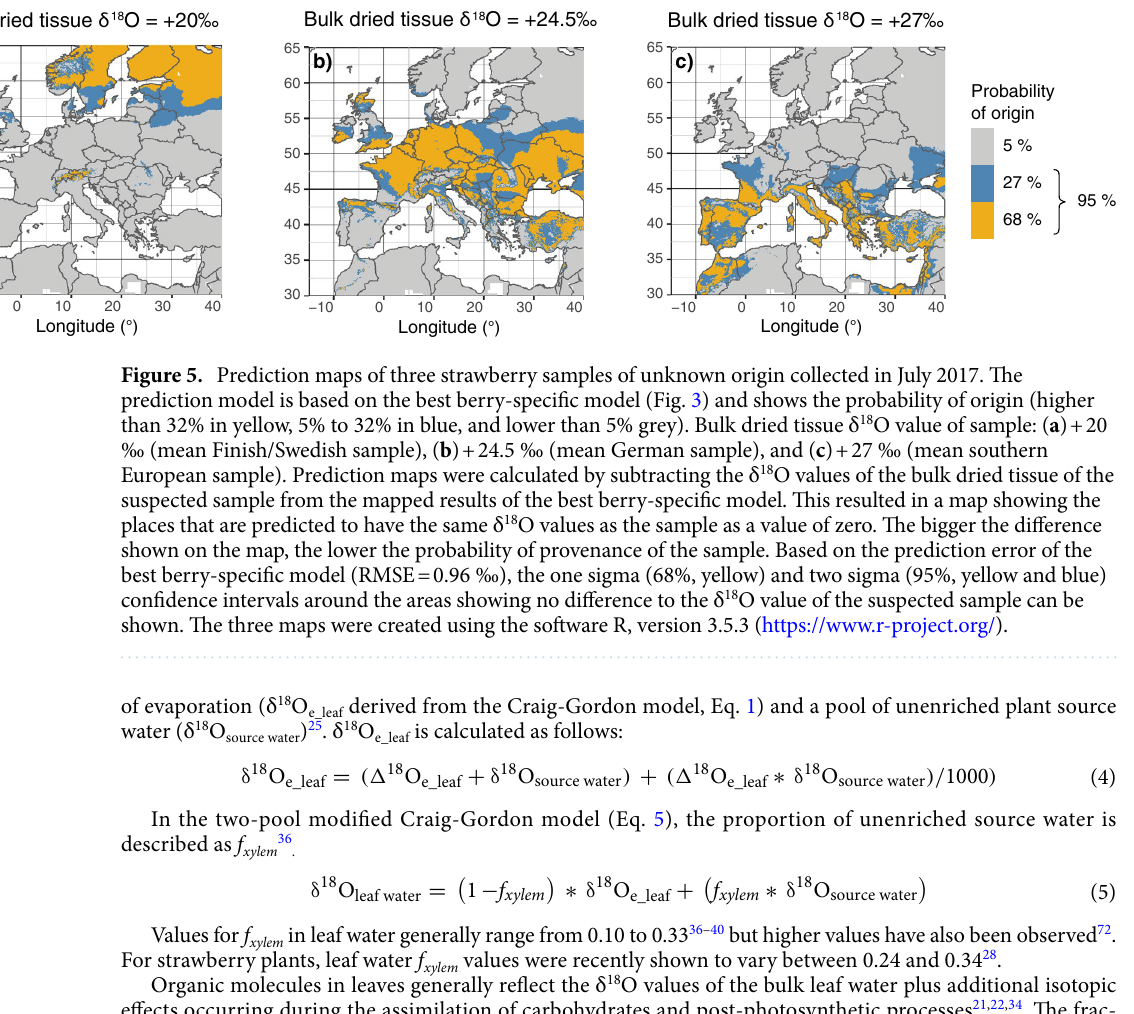
In the two-pool modified Craig-Gordon model (Eq. 5), the proportion of unenriched source water is described as f xylem 36 .